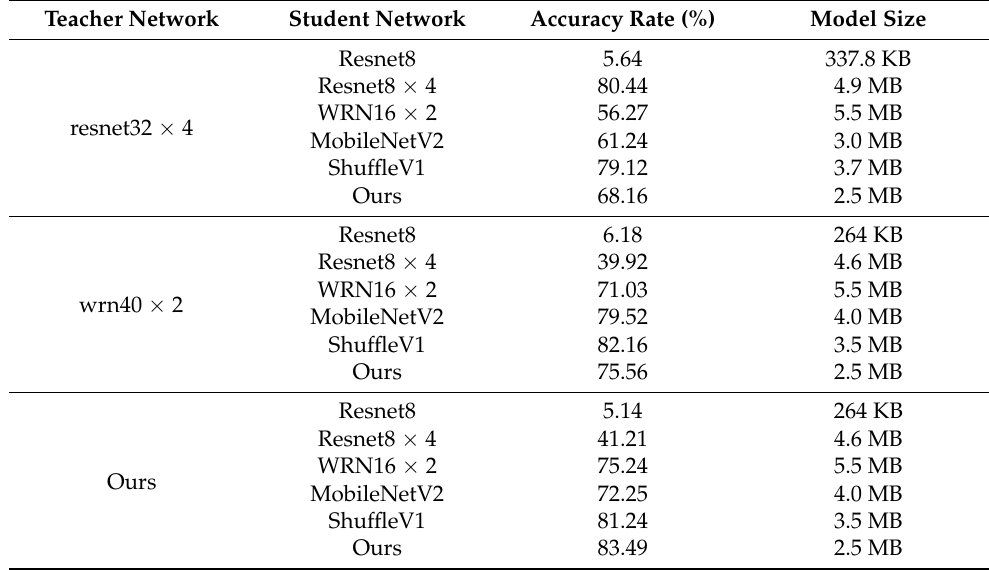
Table 4. Recognition accuracy of different teacher network and student network combinations.